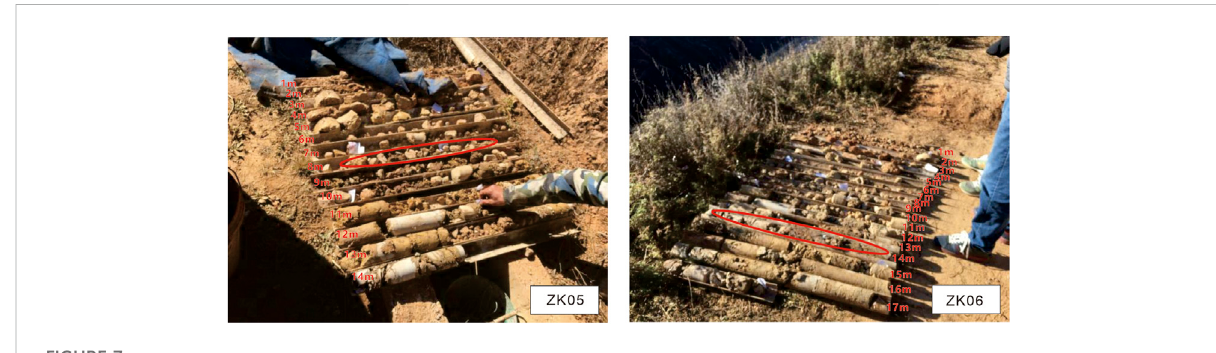
FIGURE 7 Geological drilling sample (ZK05,ZK06).